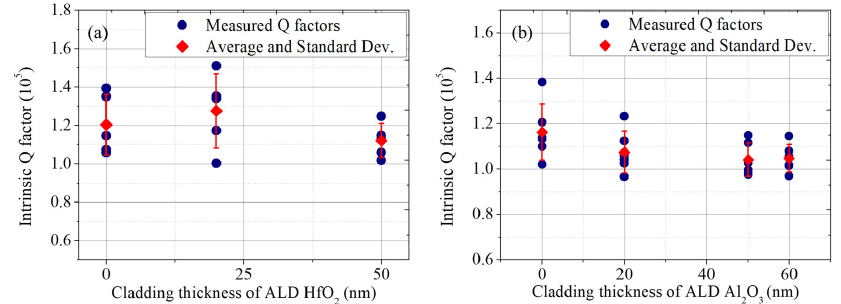
Figure 9. Intrinsic Q factors versus the ALD thickness for ( a ) HfO 2 and ( b ) Al 2 O 3 .